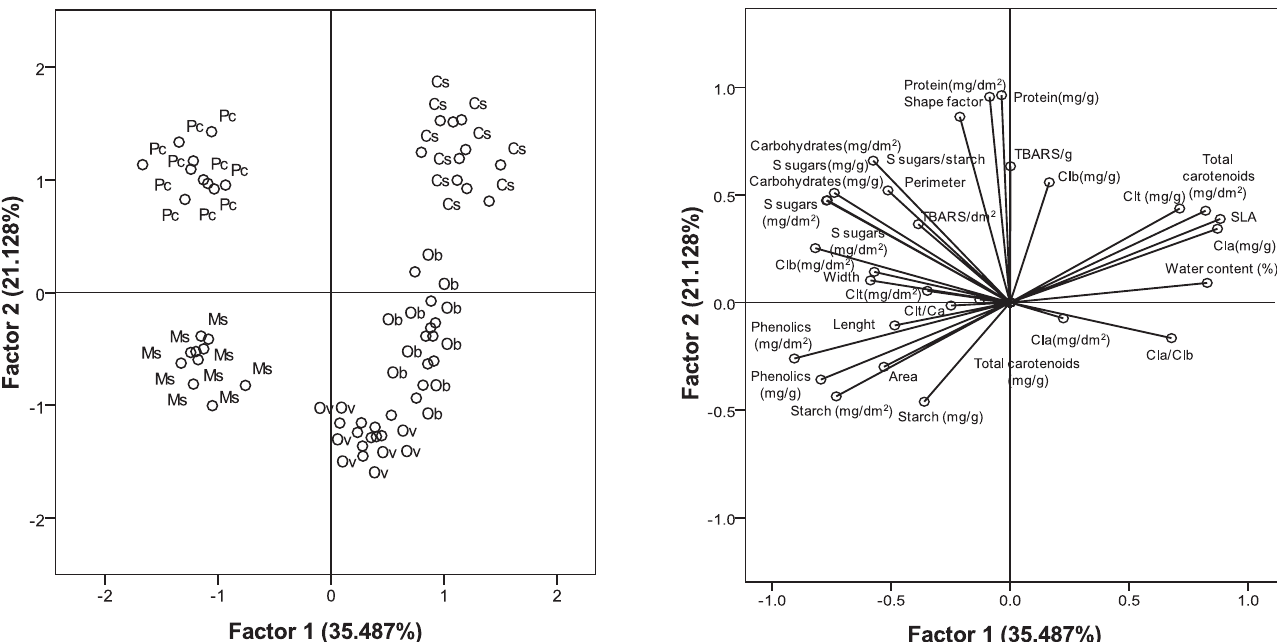
Fig. 5: Principal component analysis obtained from all analyzed parameters of five different aromatic and medicinal plants (Cs – Coriandrum sativum L.; Ms – Mentha spicata L.; Ob – Ocimum basilicum L.; Ov – Origanum vulgare L. Pc – Petroselinum crispum Mill.). PCA factors explain 56.615% of the total